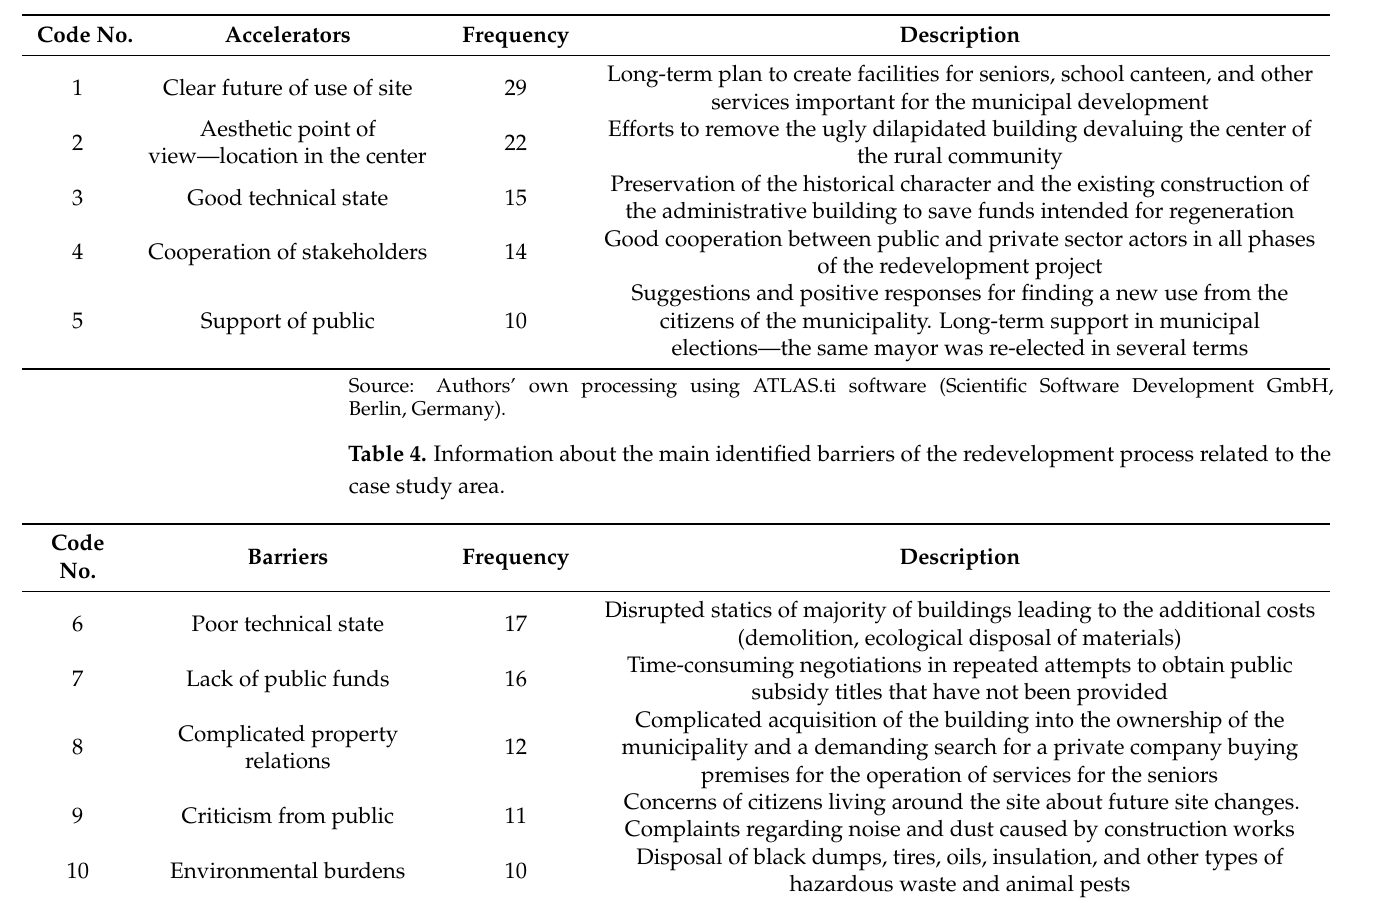
Table 3. Information about the main identified accelerators of the redevelopment process related to the case study area.